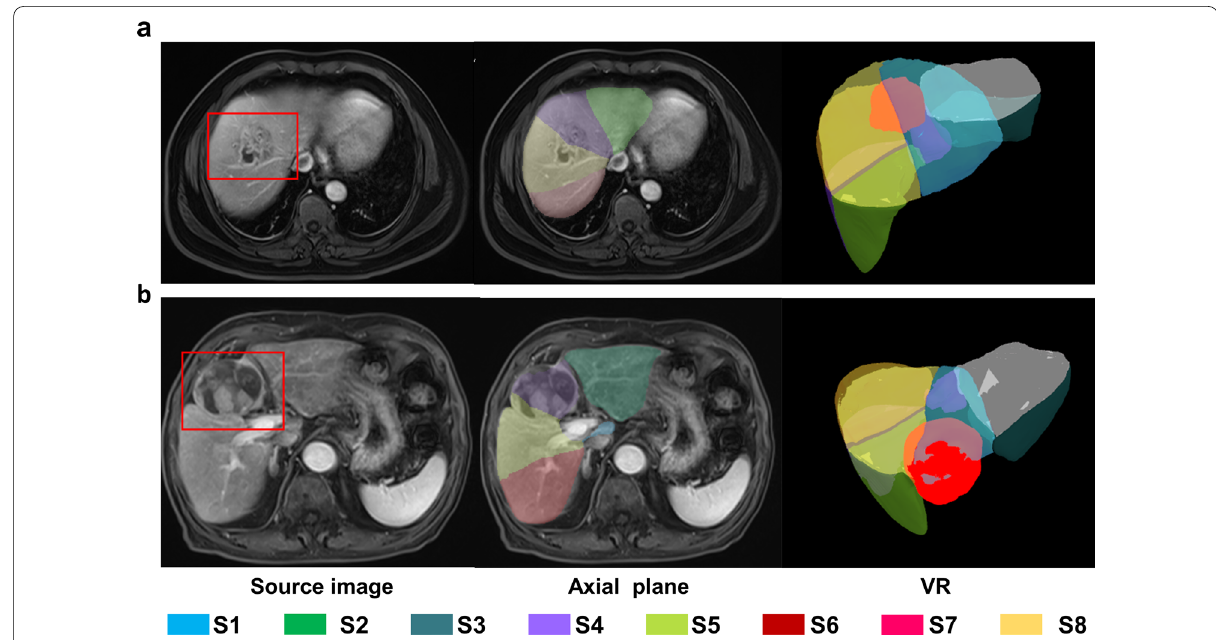
Fig. 3 Examples of indirect evaluation. a A liver abscess that resided in S4 and S8 was assigned to the correct segments by AI. b Shows a large tumor, located in S4 with slight pushing of the margin of S8. However, if we only refer to the AI segmentation result, it will be assigned to S4 and 8. The red boxes in the source image and bright red volumes in VR images indicate the lesions. AI, artificial intelligence; S, segment; VR, volume